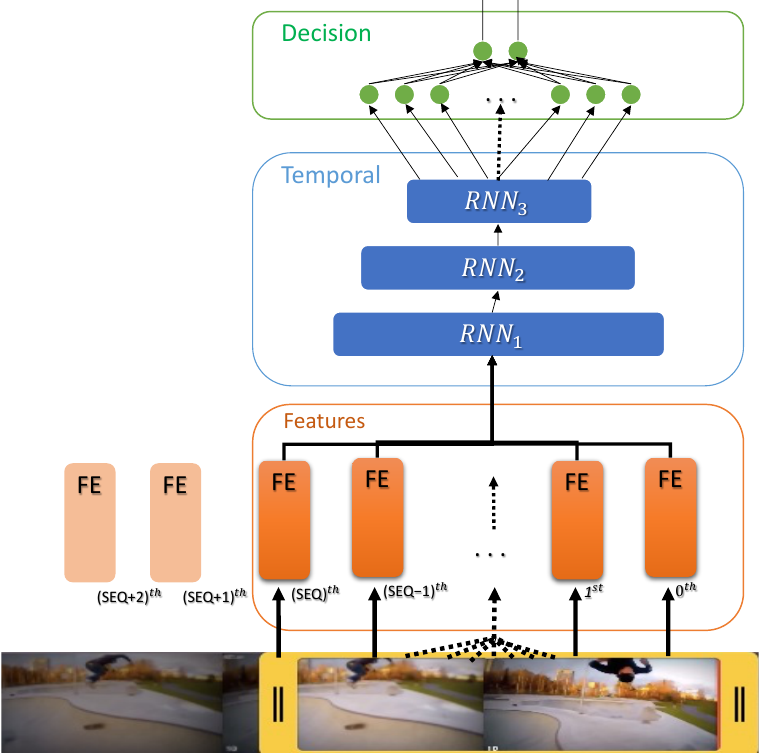
Figure 4. Proposed dynamic collision avoidance neural networks